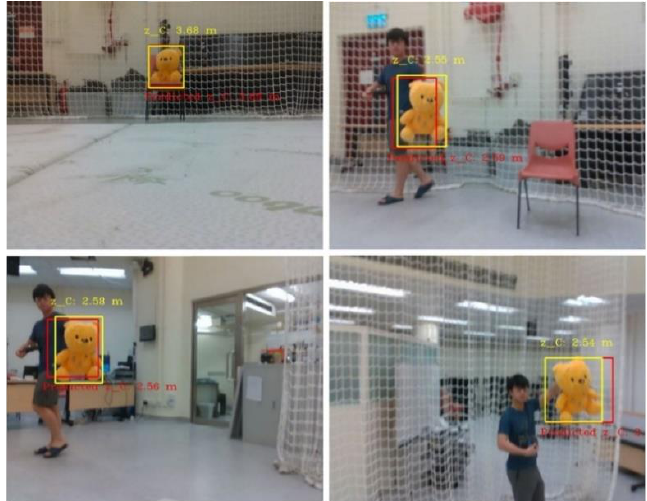
Figure 7. Flight test under the motion capture arena.